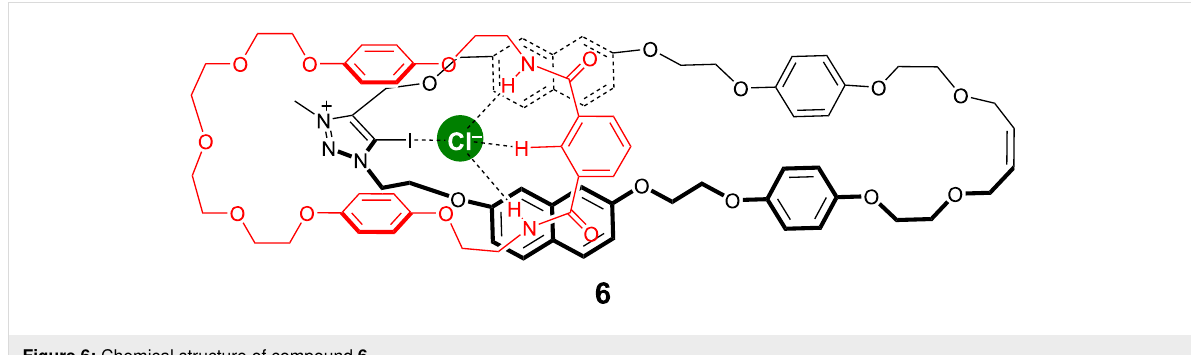
Figure 6: Chemical structure of compound 6 .